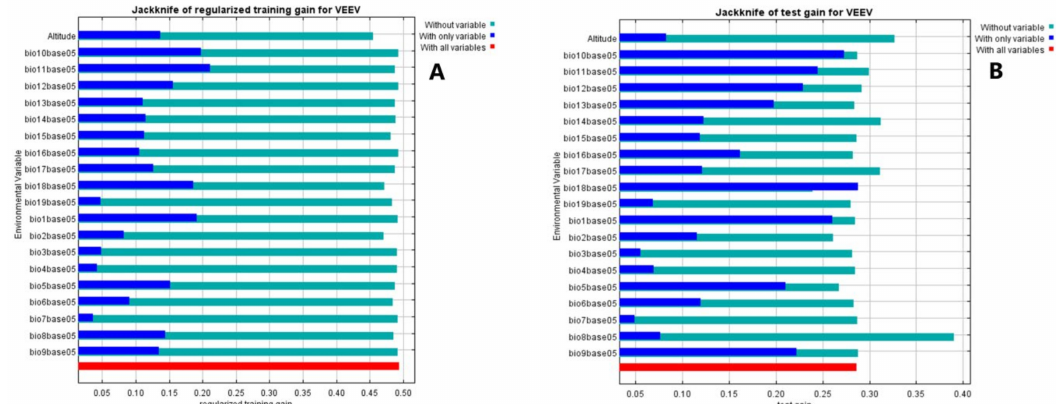
Figure 3. In the Jackknife test, a model is created using each variable in isolation and also all the variables. The blue bars show the effect of each variable over the model by itself, the light blue bars the effect in the model when this variable is not considered. The red bar represents the performance of the model when all variables are included, if a blue light bar (the model is not using this variable) is longer than the red bar, means that the predictive performance of the model improves when the corresponding variable is not used. In our case, none variable. ( A ), shows the training gain for VEEV (the full model), while ( B ) shows the test gain for VEEV (the effect of variables in the set of samples used to validate the model). The maps of the logistic and cloglog outputs are shown in the Figure S1. Whereas the map of the MaxEnt model for VEEV using the cloglog output, (Figure 4), depicts areas with higher suitability conditions for VEEV presence in warmer colors (orange-red). Black dots show the presence locations used for training, while violet dots show the test locations. The blue color represents the region with a low odd of VEEV presence.